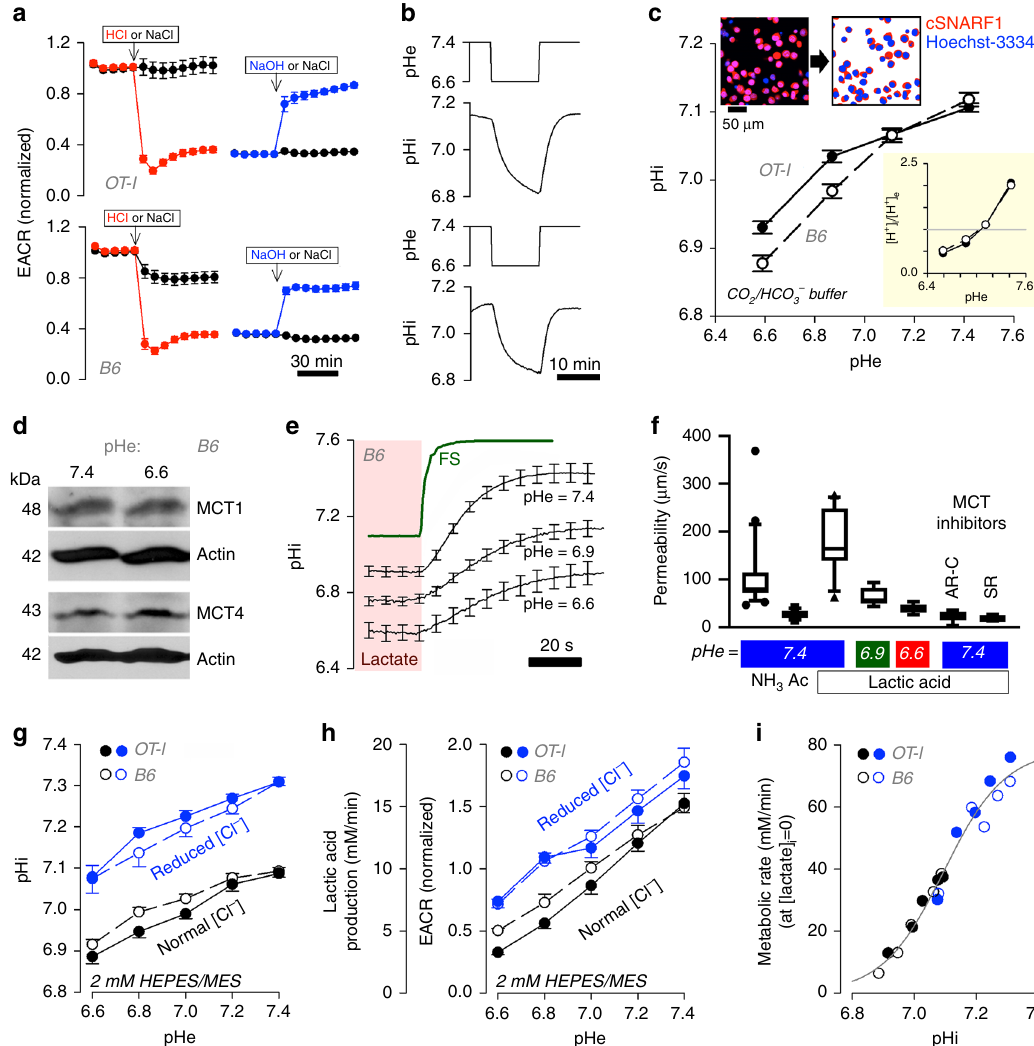
Fig. 3 Mechanism of T-cell glycolysis inhibition by low pH. a An injection of HCl abruptly reduces extracellular acidi fi cation rate (ECAR) in OT1 and B6 T- cells; this reverses upon an injection of NaOH. NaCl injections performed as sham controls. Solutions were lightly buffered with 2 mM HEPES/MES mixture and titrated to desired pH. Mean± SEM ( n = 4 biological replicates). b A reduction in extracellular pH (pHe) evokes a delayed fall in intracellular pH (pHi), as measured from cSNARF1 fl uorescence (2 mM HEPES/MES mixture). Mean of 10 time course recordings; error bars not shown for clarity. c Fluorescence imaging of cells under superfusion with CO 2 /HCO 3 − buffer. Cells co-loaded with cSNARF1 (red) to report pH and Hoechst-33342 (blue) to exclude nuclear areas from the analysis. Plot shows relationship between pHe and pHi at the steady-state in OT1 and B6 cells. Note the transmembrane [H + ] gradient, shown in inset, inverts near resting pHi. Mean ± SEM of 5 recordings of fi elds of view containing 40 – 60 cells. d Western blot for MCT1 (48 kDa) and MCT4 (43 kDa) relative to actin (42 kDa) on lysates collected from B6 T-cells that had been incubated at pHe 7.4 or 6.6 (N = 3). (See Supplementary Fig. S17 for full blot). e Measuring total MCT activity from the rate of pHi change driven by transmembrane lactate ef fl ux. T-cells under superfusion were equilibrated with one of the three conditions, 30 mM lactate at pHe 7.4, 15 mM lactate at pHe 6.9 or 7.5 mM lactate at pHe 6.6. Note that, for lower pHe, the lactate concentration was reduced to ensure that comparable levels of lactic acid are present at equilibrium. Rapid switching to lactate-free solution at the same pHe evoked net lactate ef fl ux. Apparent permeability to lactic acid can be calculated from the rate of pHi change, buffering capacity and transmembrane gradient. To con fi rm that the ensuing pHi response was not rate-limited by the speed of solution exchange, one solution was labelled with fl uorescein sulphonic acid (FS) and the rate of fl uorescence-change indicated an exchange time constant of 2.6 s. Mean ± SEM of 10 cells per condition. f Apparent membrane permeability for NH 3 (added as 15 mM NH 4 Cl; n = 21) acetic acid (Ac; 30 mM NaAcetate; n = 12) and lactic acid (7.5 – 30 mM Na Lactate) at high ( n = 12), intermediate ( n = 6), and low ( n = 8) pHe. Indicated experiments performed in the presence of MCT inhibitors AR-C (AR- C155858; 10 µ M; n = 7) and SR (SR13800; 10 µ M;; n = 7). Mean ± S.E.M. of 7 – 15 cells per condition. Box shows median and 25 – 75% percentiles and whiskers show 10 – 90% percentile. g Steady-state relationship between pHe and pHi mapped for 2 mM HEPES/MES solution containing either normal (140 mM) or reduced [Cl] (7 mM), iso-osmotically substituted with gluconate to offset pHi at constant pHe. Mean±SEM of 6 recordings with 40 – 60 cells each. h EACR, calibrated to units of lactic acid-production rate (mM/min), is shown not to be a unique function of pHe; Data shown are Mean± S.D., n = 14 wells over two independently seeded plates. i Data from g and h analyzed to generate a relationship between metabolic rate, extrapolated to lactate-free conditions (see Eq. (1)). Best- fi t is a simple function of pHi, described by a Hill